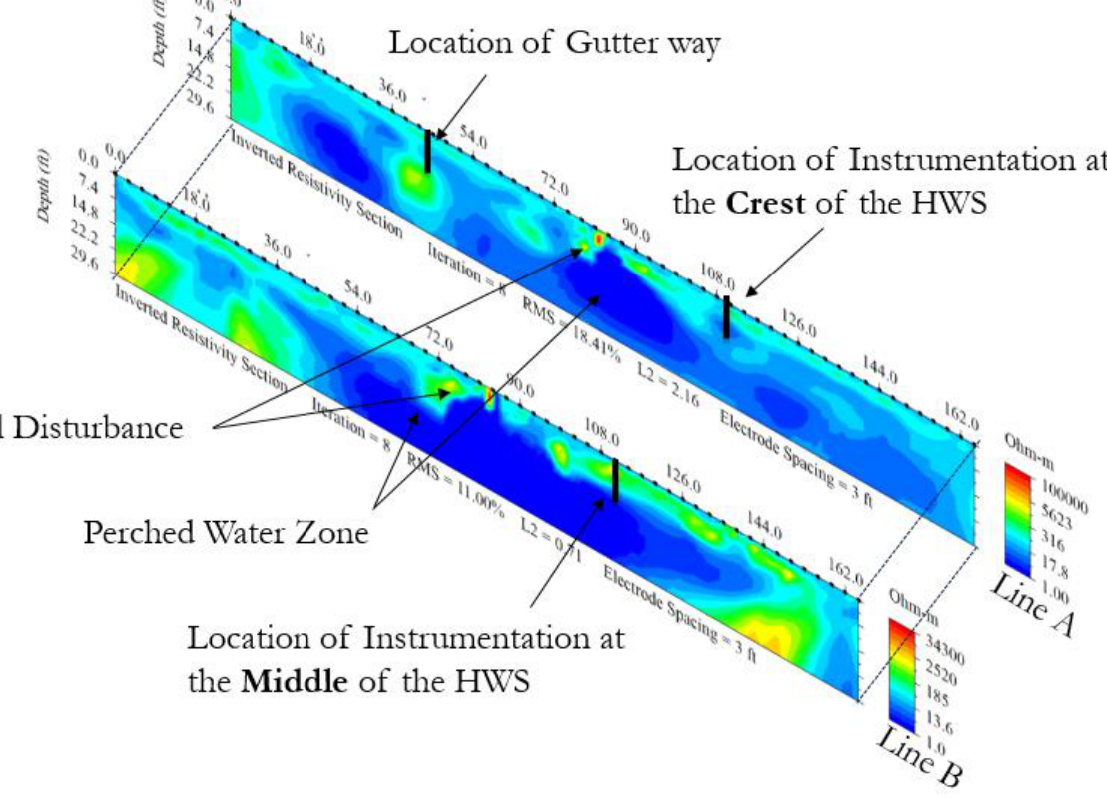
Figure 22. HWS 4, 2D ERI test profile at line A and at line B tested on 11 January 2021 (1 ft = 0.3 m).